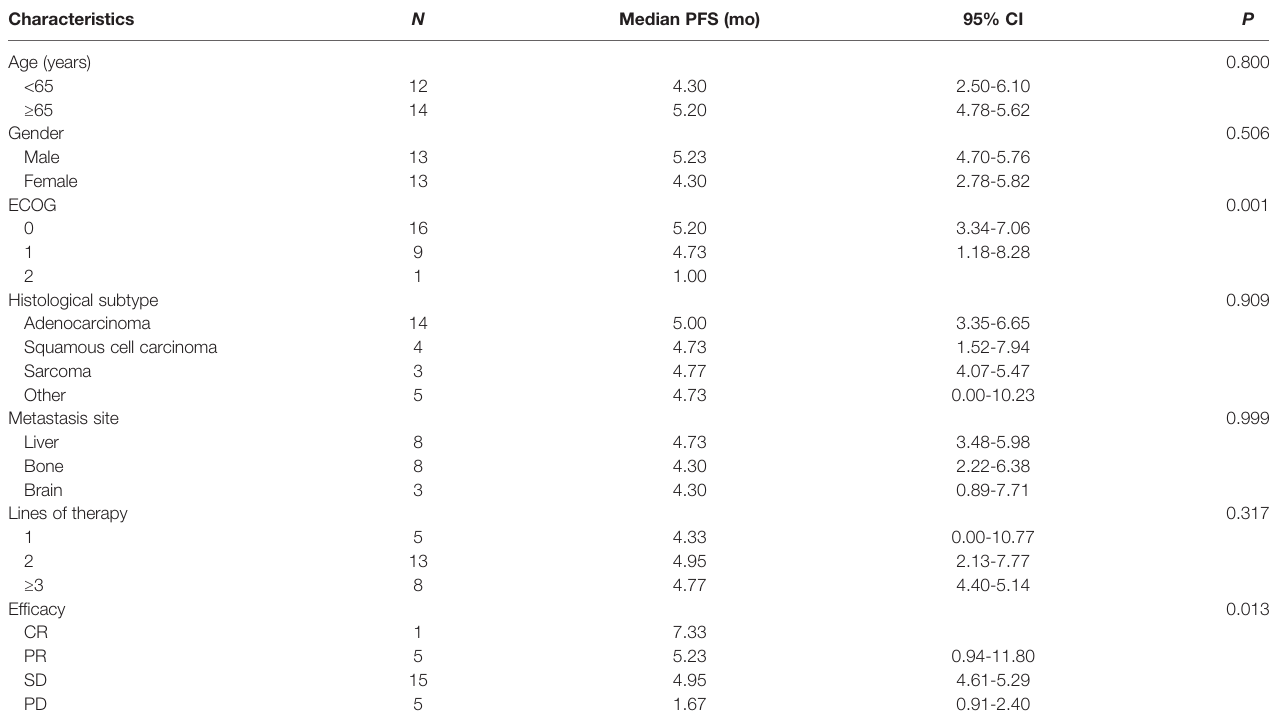
TABLE 3 | Univariate analysis of correlation between clinical characteristics and median progression-free survival (PFS). Characteristics